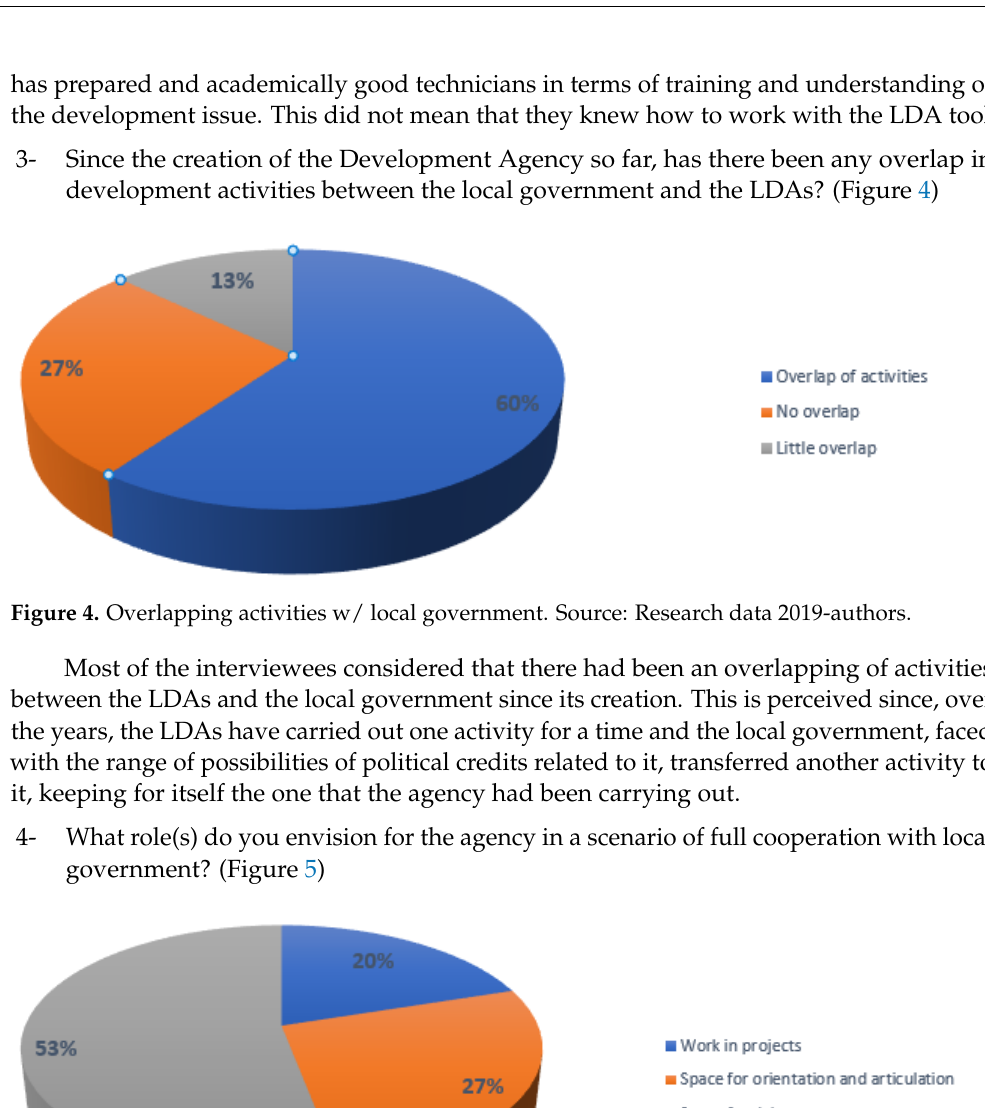
Figure 3. Sharing activities w/ local government. Source: Research data 2019-authors.